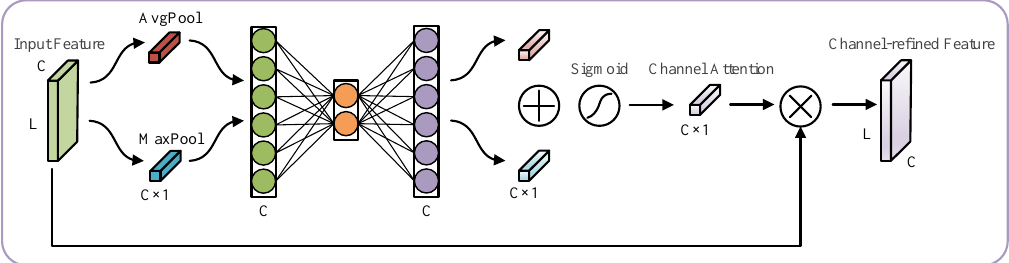
Figure 2. Structure of the CBAM.